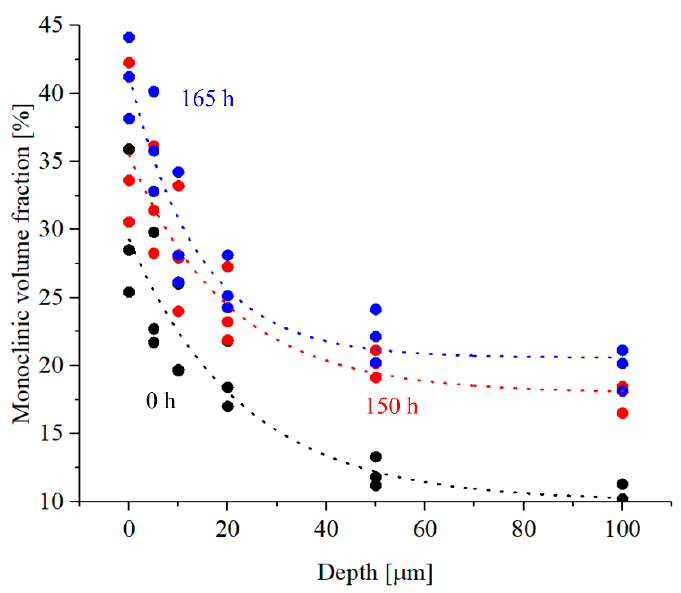
Figure 10. In-depth profile of monoclinic volume fraction as a function of hydrothermal ageing, as measured by Raman spectroscopy using the Karagiri equation.